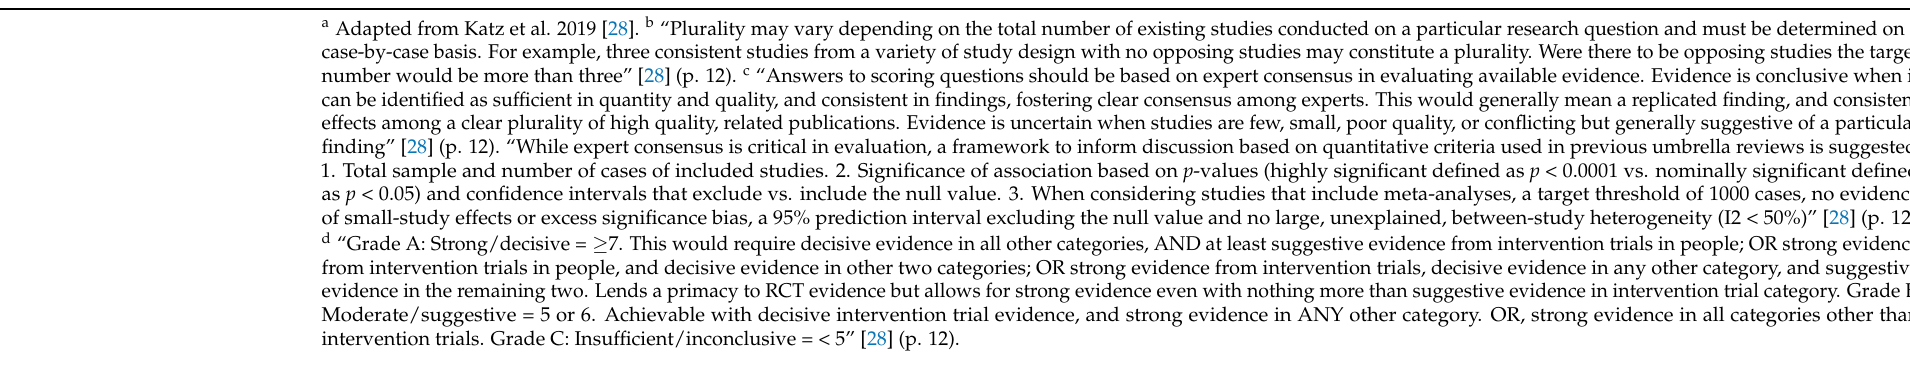
Q1: Are there established mechanisms of action? A plurality b of evidence from bench science and animal